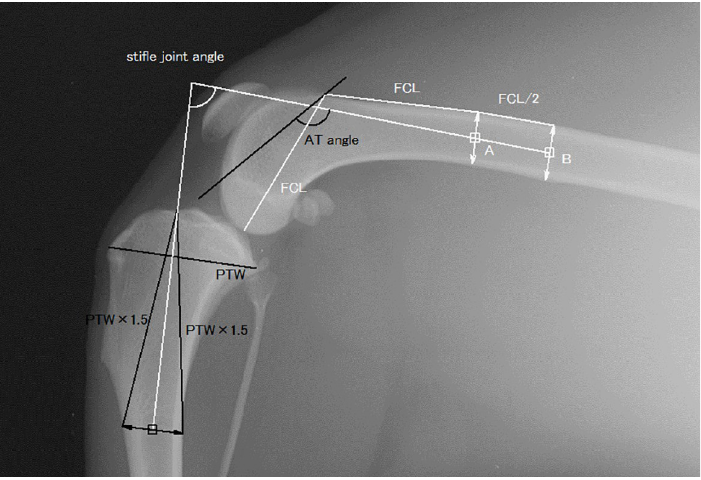
Fig 1. The measurement definitions of the joint angle and anatomical trochlear angle (AT angle). The joint angle (white arc) was measured as the caudal angle of the anatomical axes of the femur and tibia. The distal femoral anatomical axis was defined as the extension of the line connecting the two points (white squares, A and B). The distal point A was the centre of the femoral width, which was one femoral condyle length (line FCL) away from the proximal extremity of the trochlea, and the proximal point B was half the FCL away from the distal point. The proximal tibial anatomical axis was defined as the extension of the line connecting the centre of the tibial width (black square) and the notch at the front of the tibial plateau. The tibial width was measured at the tibial cortex, which was 1.5 times the length of the proximal tibial width (PTW) away from the notch at the front of the tibial plateau. The AT angle was measured as the caudal angle made by the femoral anatomical axis and the femoral trochlear